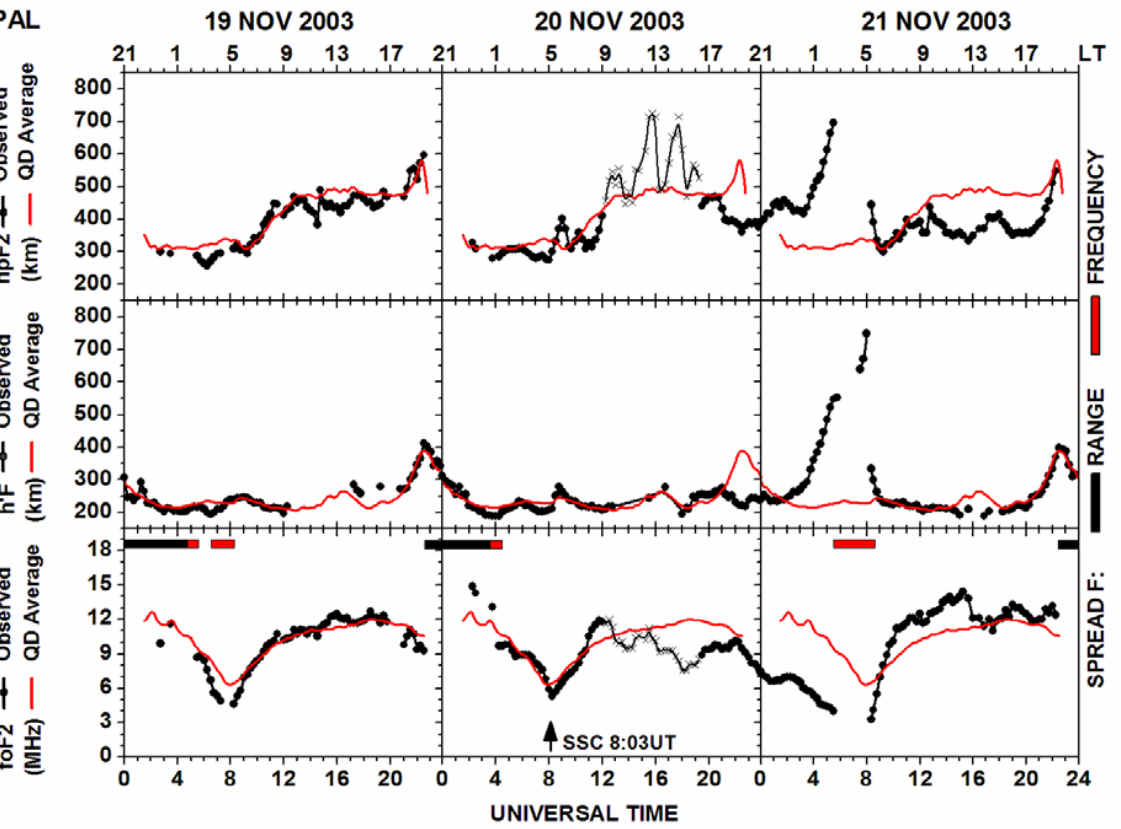
Fig. 3. The variations of h 0 F, fo F2 and hp F2 (black dots with line) during the period 19–21 November 2003 observed at Palmas (PAL), Brazil. The average quiet-day variations of h 0 F, hp F2 and fo F2 (red line) are also